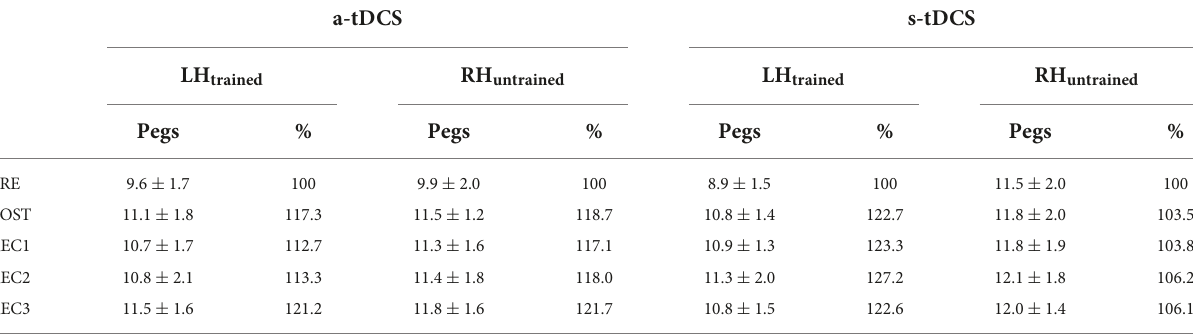
TABLE 2 Overview of raw Grooved Pegboard Test performance (number of pegs) and percentage improvement (normalized to values obtained at PRE) for both groups (a-tDCS, s-tDCS) for LH trained and RH untrained